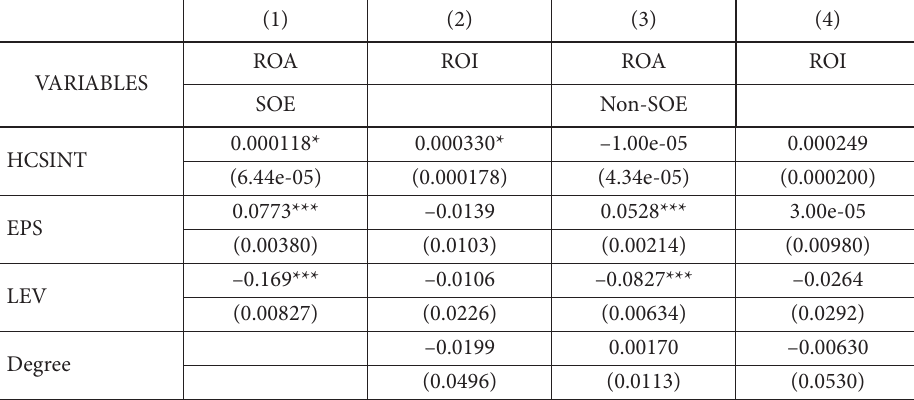
Table 4. 2sls instrumental regression (hierarchical CEO succession intensity, SOEs and Non-SOEs